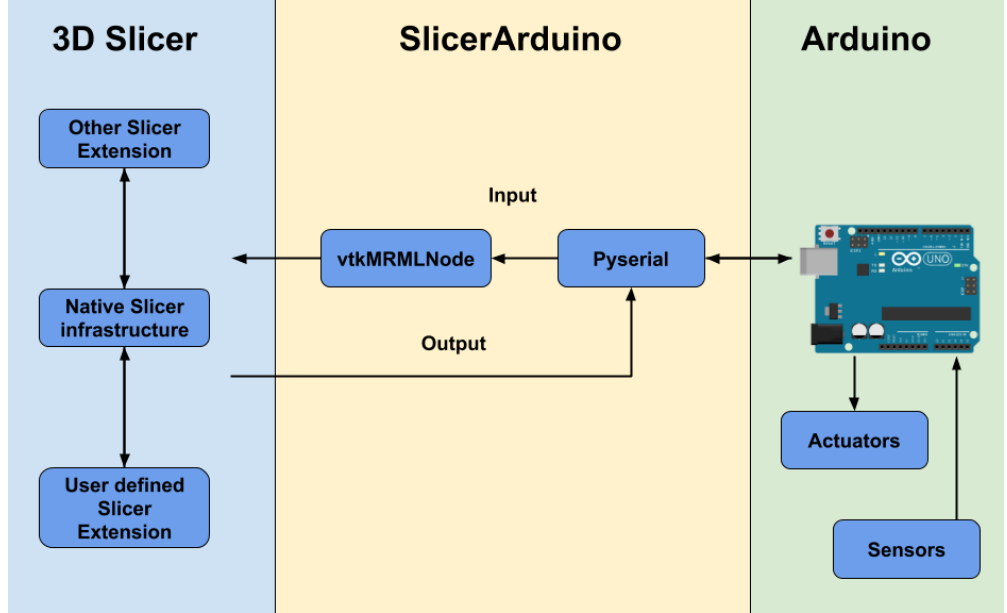
Figure 3. Graphical concept of SlicerArduino